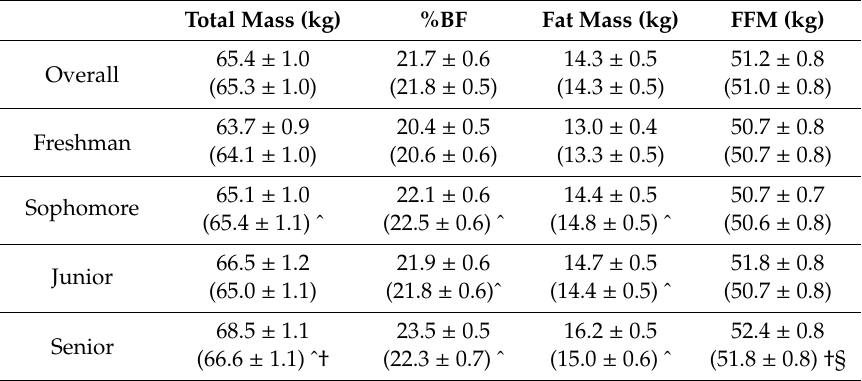
Table 1. Observed and adjusted means for body composition measures overall and across grade levels, averaged over a competitive soccer season *.